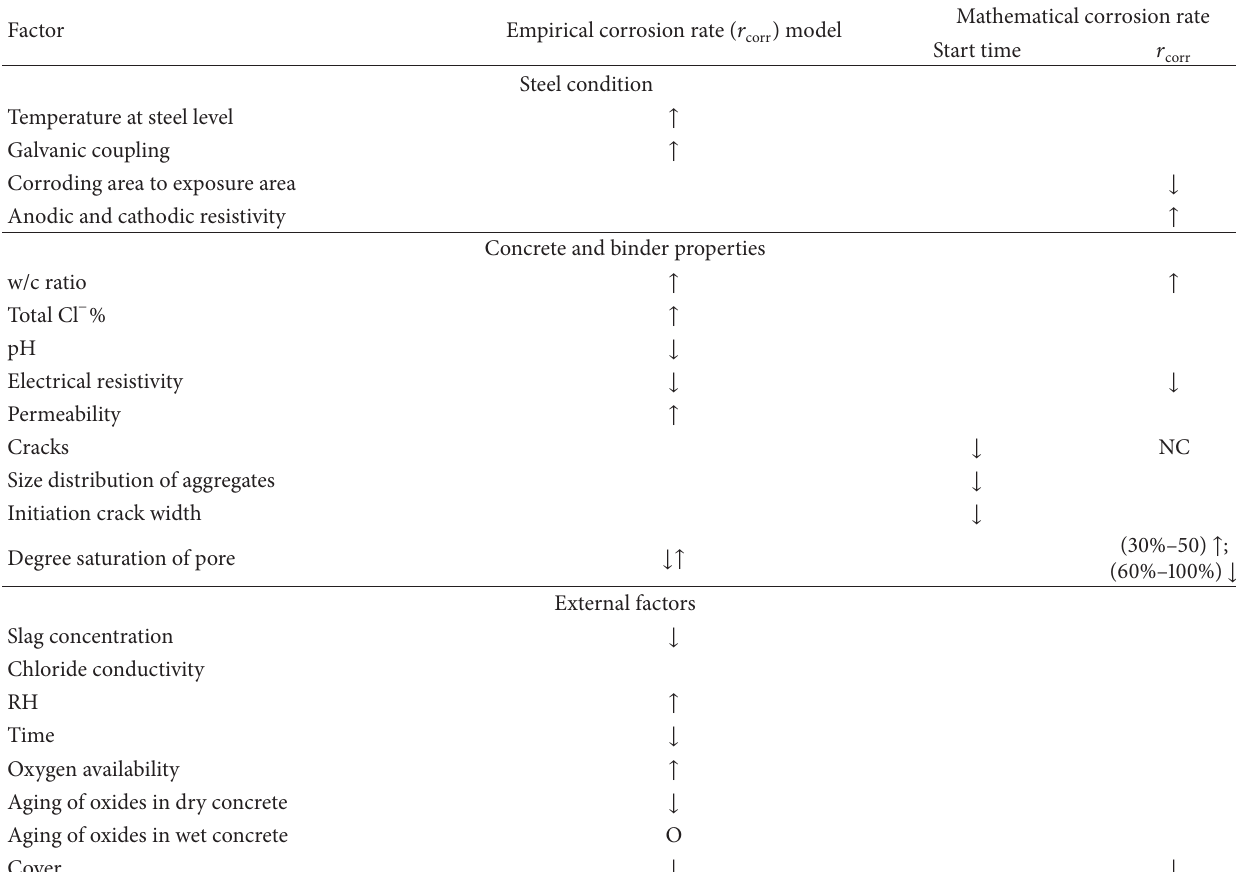
Table 4: Important factors and their effects on corrosion rate and start time of corrosion.